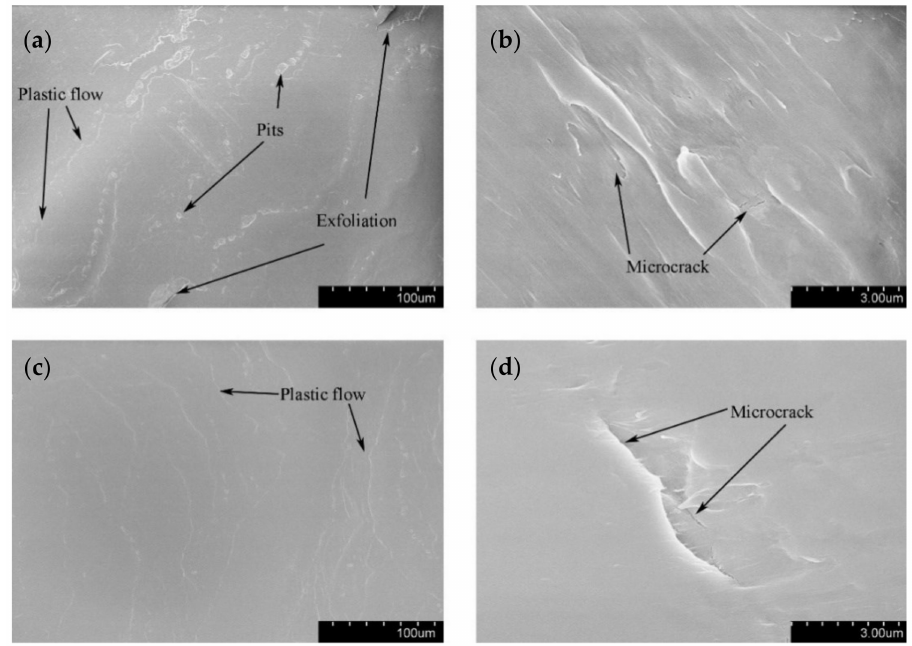
Figure 15. The SEM morphology of PVDF films in the contact region with ƒ = 15 Hz, D = ±20 μm, and V c = 0 V: ( a, b ) F n = 15 N and ( c, d ) F n = 50 N.